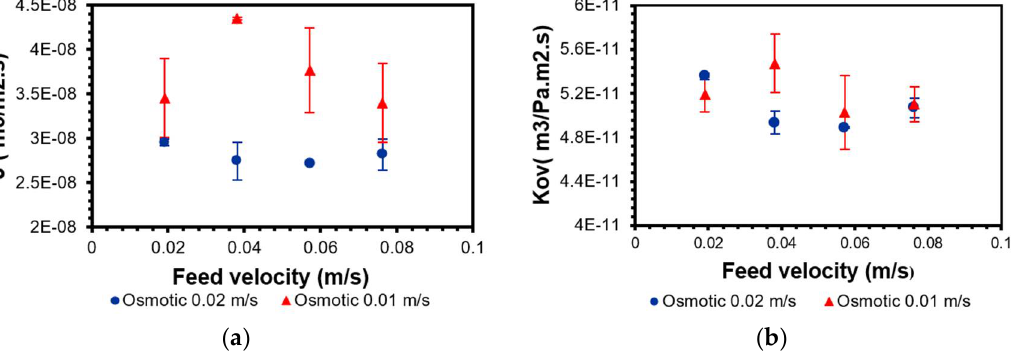
Figure 3. Effect of feed and osmotic velocities on ( a ) flux and ( b ) K ov . The concentration of the NaHCO 3 was at a maximum, and feed and osmotic solutions were at room temperature.